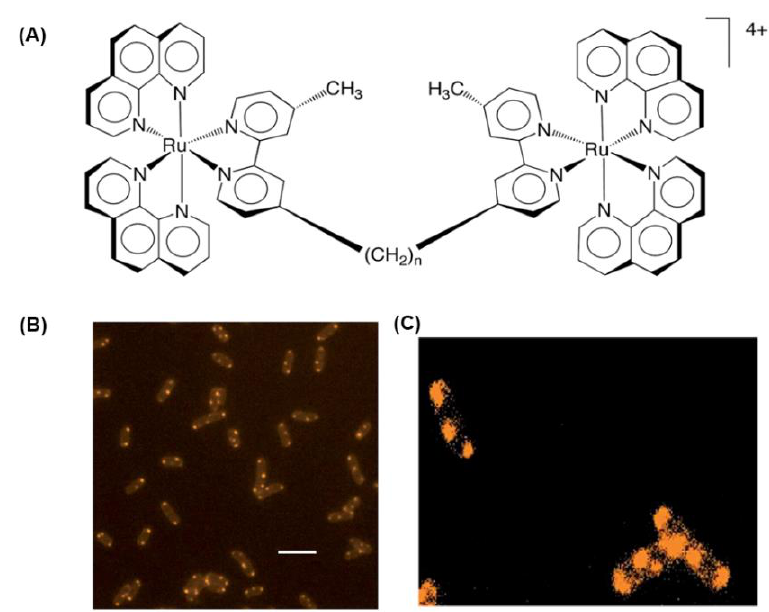
Figure 4. ( A ) The structure of the dinuclear polypyridyl ruthenium(II) complexes Rubbn, where n = 2, 5, 7, 10, 12 and 16; ( B ) phosphorescence fluorescence microscopy images of Rubb16 localization in E. coli MG1665 cells at MIC concentration (4 mg/mL), scale bar = 5 µ m; ( C ) Rubb16 localization in E. coli MG1665 cells at twice the MIC concentration with the image re-processed to enhance the luminescence of the Rubb16 outside of the foci (reproduced from Reference [56]).